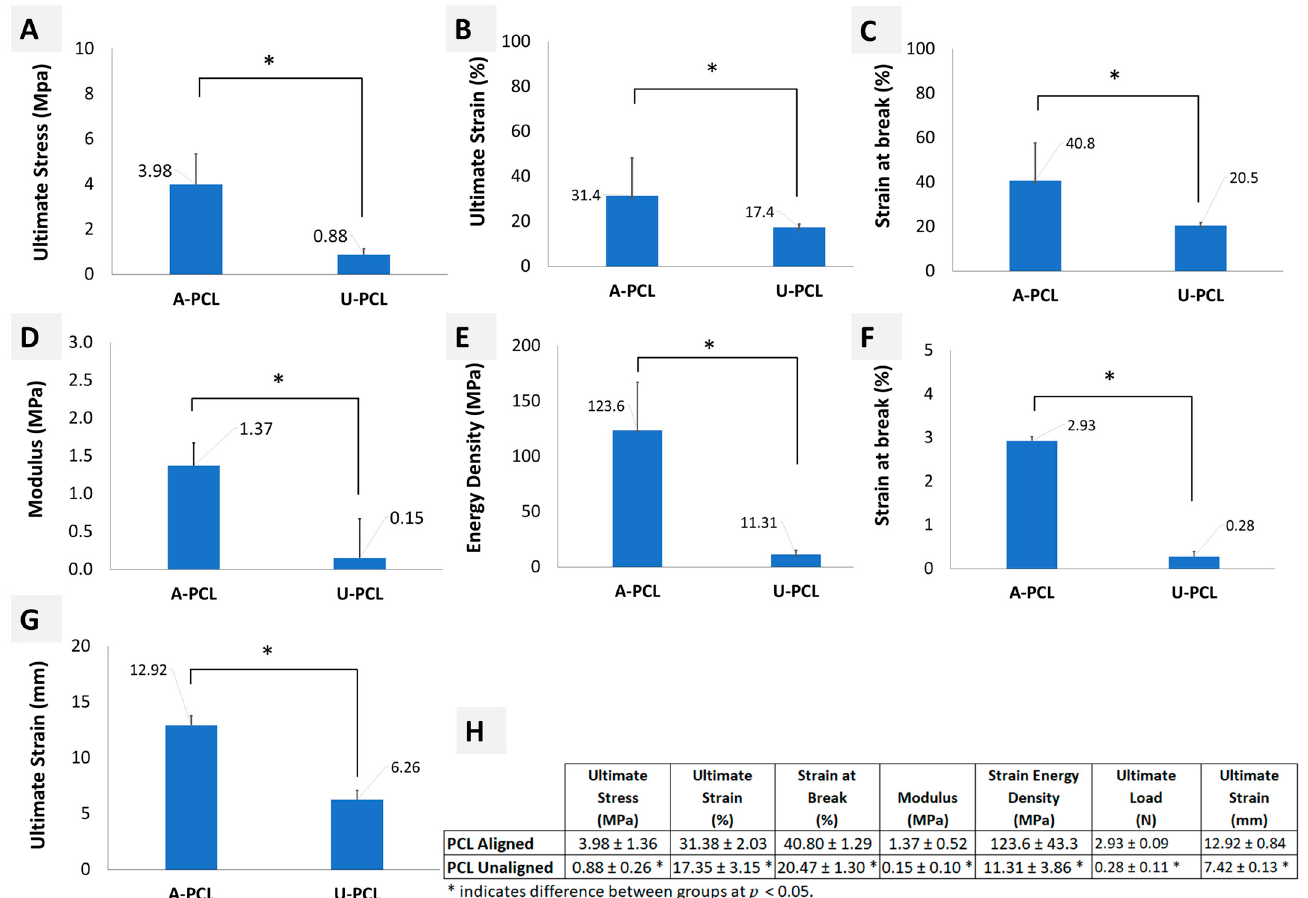
Figure 8. Mechanical properties of aligned (A ‐ PCL) and unaligned (U ‐ PCL) PCL scaffolds ( A – G ), and descriptive statistics ( H ). * indicates significant difference at p < 0.05 determined using Student’s t ‐ test. Error bars represent SD.